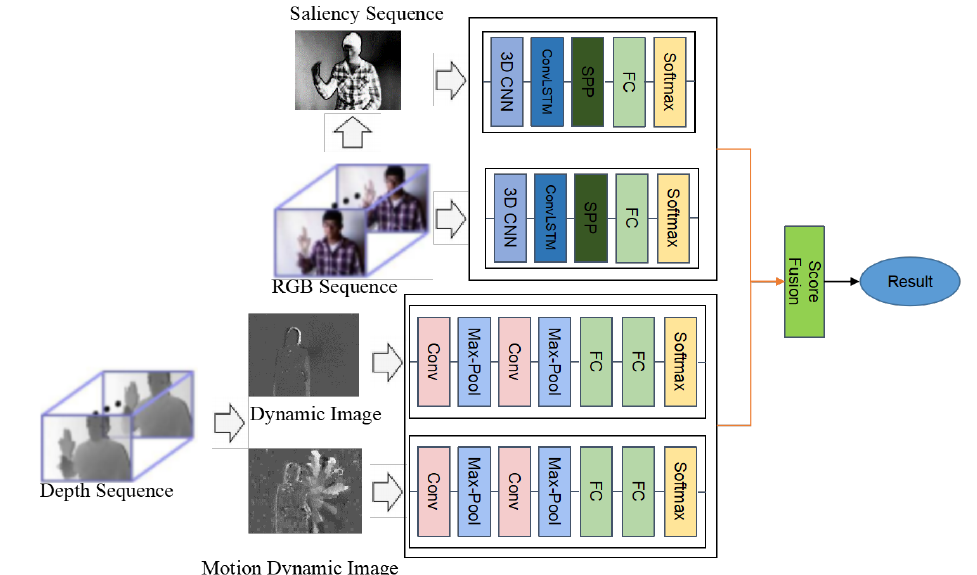
Figure 7. The overview of the proposed gesture recognition